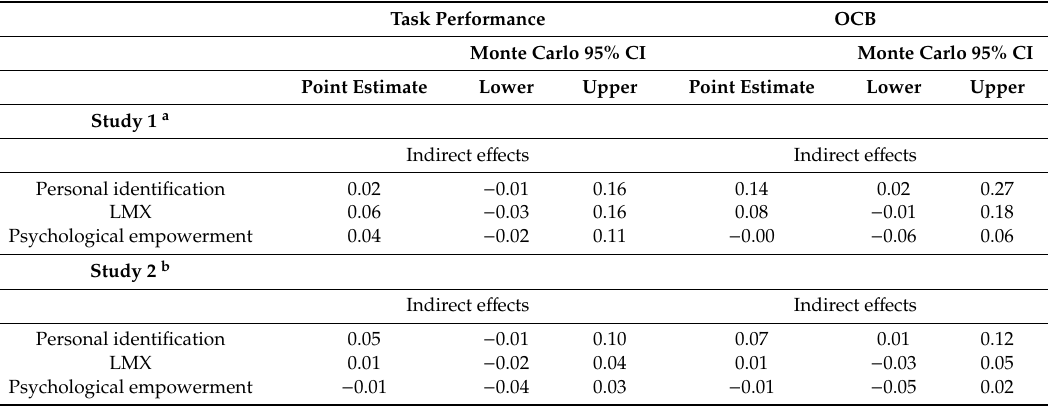
Table 4. Multiple Mediating E ff ects of Transformational Leadership on Employee Performance, Asymmetric (Monte Carlo) Confidence